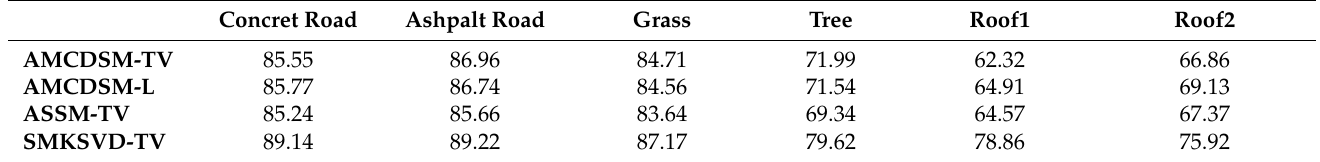
Table 12. HYDICE urban hyperspectral data: accuracies of each